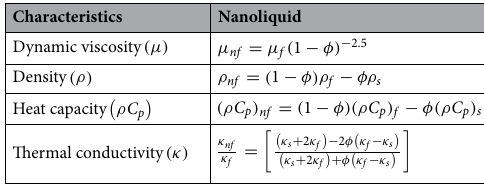
Table 1. Thermo-physical structures related to nanofluids.